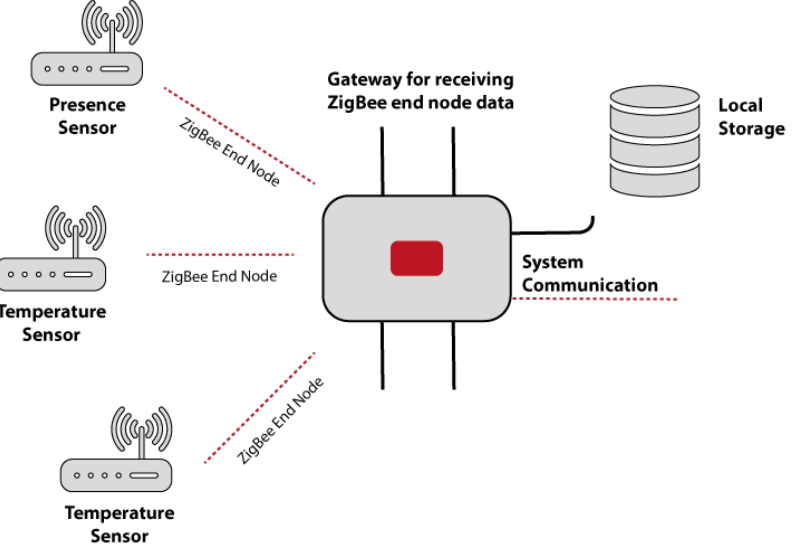
Figure 5. Transmission through the ZigBee protocol of the data collected by the sensors.